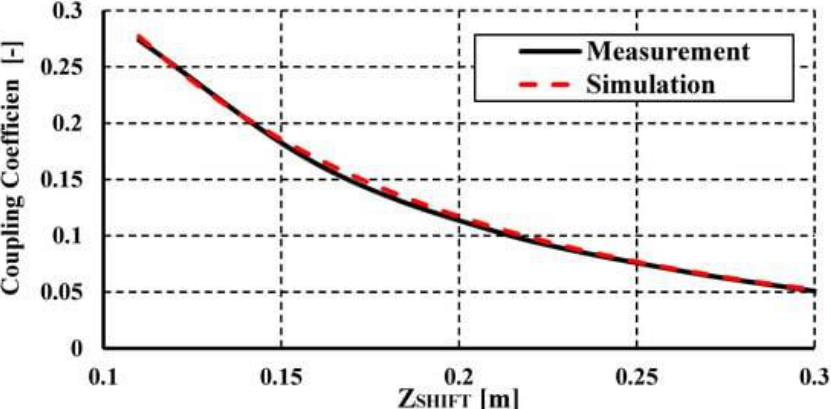
Figure 3. Presented in [3] as Figure 5. Model verification — coupling coefficient dependency on trans- fer distance. transfer